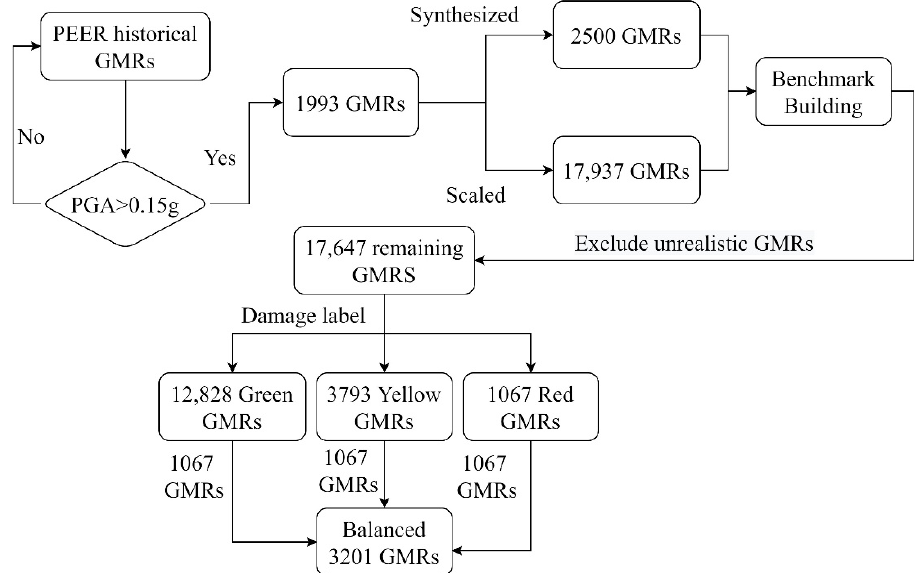
Figure 5. The diagram of selecting the balanced dataset of 3201 GMRs.